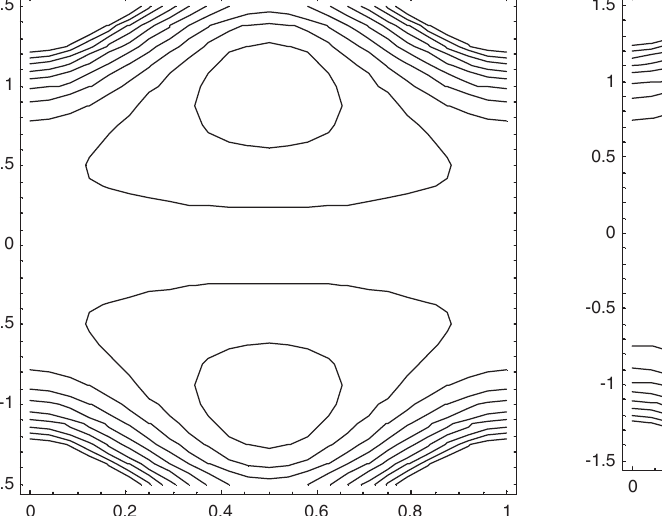
Fig. 18. Streamlines in the wave frame when Q =0.9, φ =0.6, M =1.0, N =0.5.